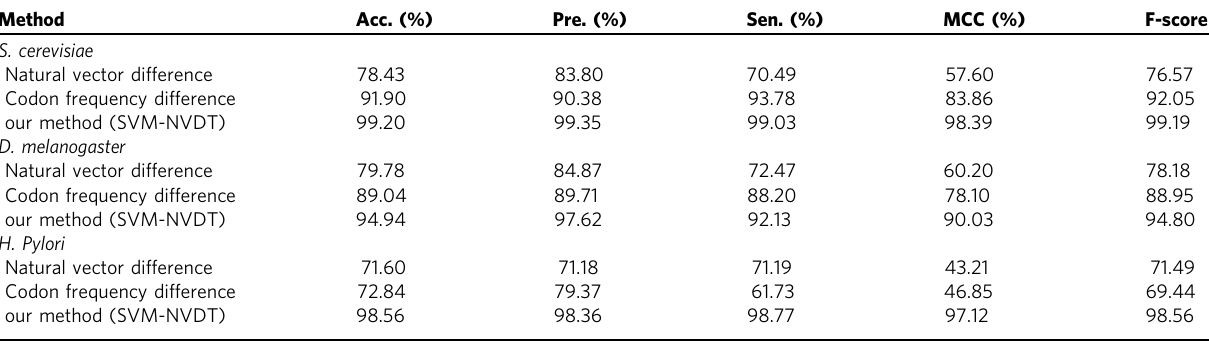
Table 4 Prediction results of different methods on three constructed independent test